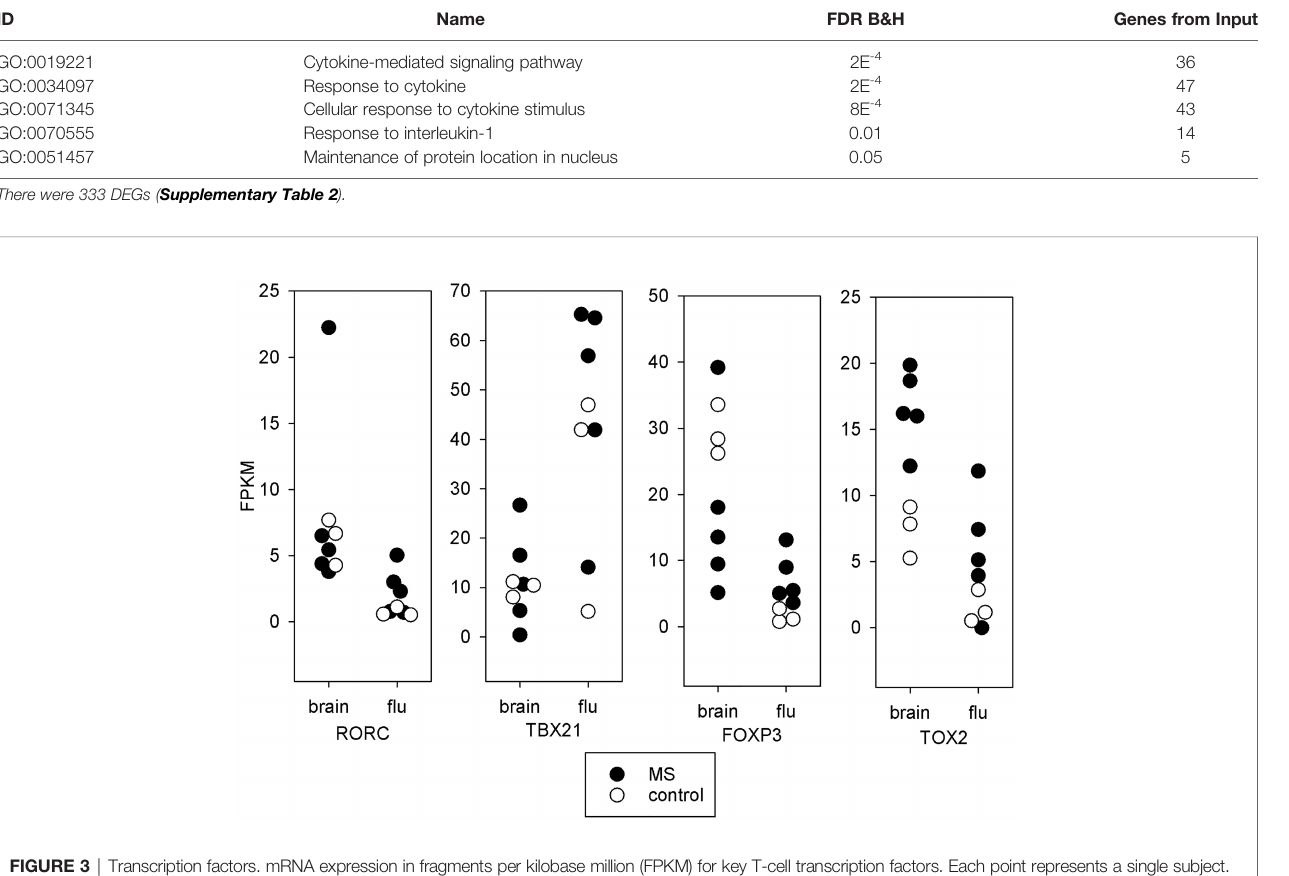
FIGURE 3 | Transcription factors. mRNA expression in fragments per kilobase million (FPKM) for key T-cell transcription factors. Each point represents a single subject. Solid symbols are the 5 MS subjects and open symbols are the 3 controls. The brain stimulated cells from MS patients tend towards a Th17 or Tfh expression pattern. The brain stimulated cells from controls express increased FOXP3 relative to fl u-stimulated cells. This is not seen in the MS